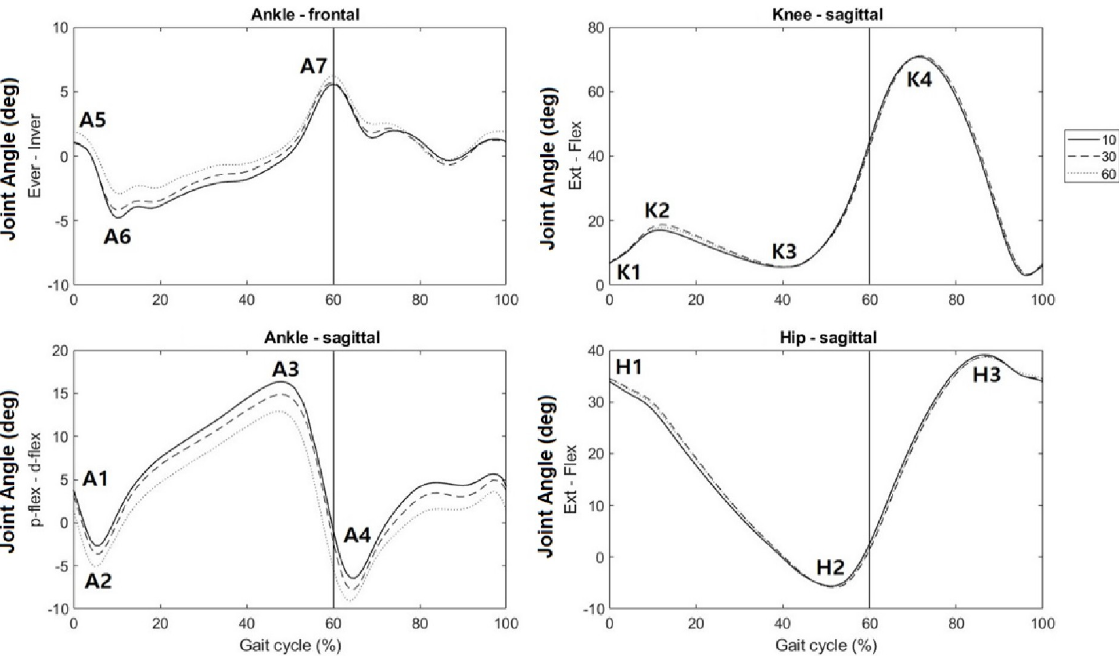
Fig 2. Averaged ankle, knee, and hip joints angle during walking with three shoe